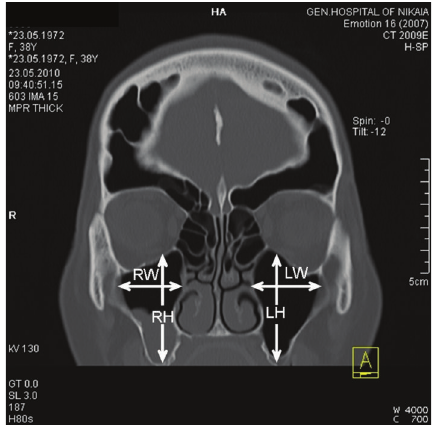
Figure 4: The frontal lobe looks smaller in size due to the enlargement of the frontal sinus. Linear measurements of maxillary sinus (RW: width of the right sinus, LW: width of the left sinus, RH: height of the right sinus, and LH: height of the left